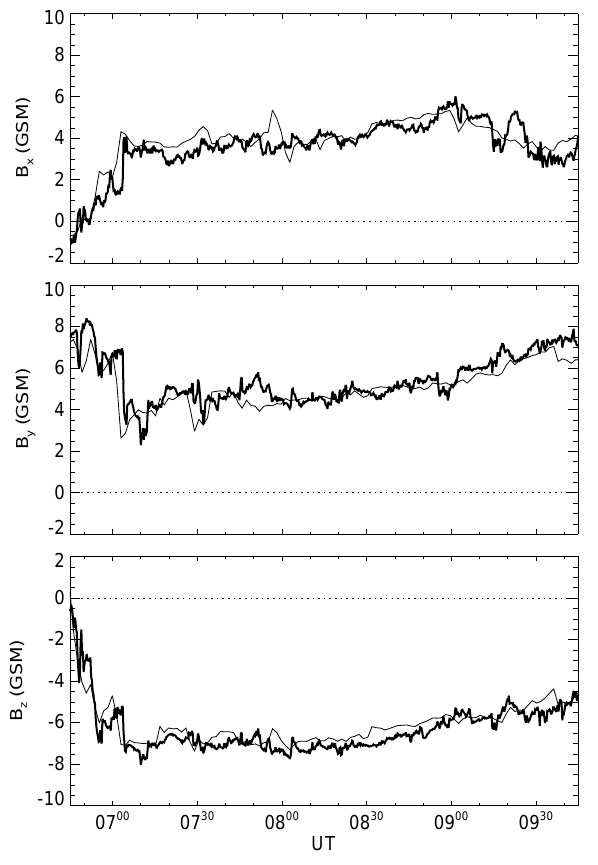
Fig. 2. Interplanetary magnetic field (IMF) observations from the ACE and Wind spacecraft, between 06:45 and 09:45UT on 23 November 1999. Panels, from the top, illustrate the X , Y and Z components of the IMF in geocentric solar magnetic (GSM) co- ordinates for both the ACE (thick line) and Wind spacecraft (thin line). Data are corrected to account for the time delay from the spacecraft to the subsolar point, as discussed in the text. Magnetic field values are in nanoTeslas